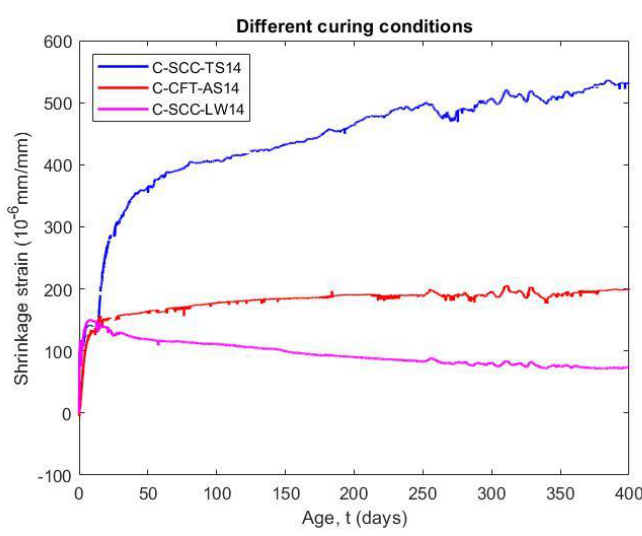
Figure 9. S hrinkage of CFT and SCC measured at initial setting time. Figure 9. Shrinkage of CFT and SCC measured at initial setting